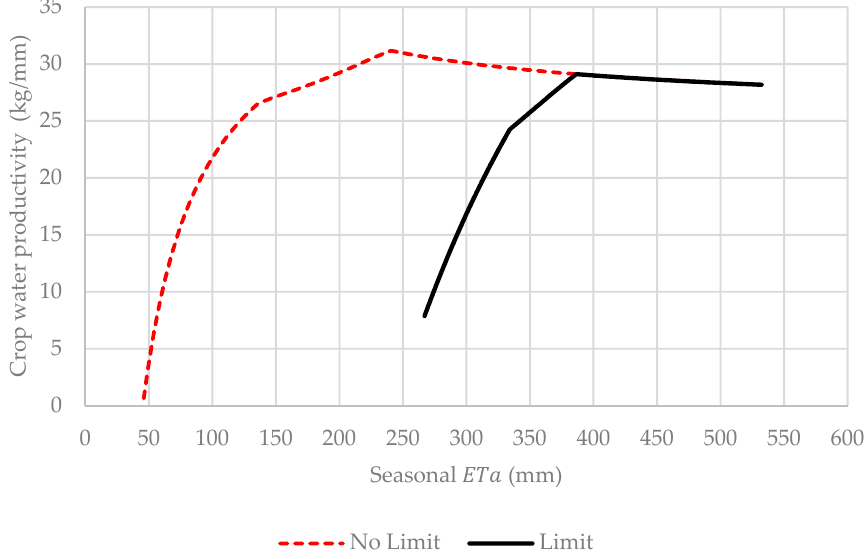
Figure 6. Calculated Stewart multiplicative crop water productivity for a no stage specific stress limit (No Limit) and a 50% stage specific limit on actual evapotranspiration ( ETa ) deficits (Limit).